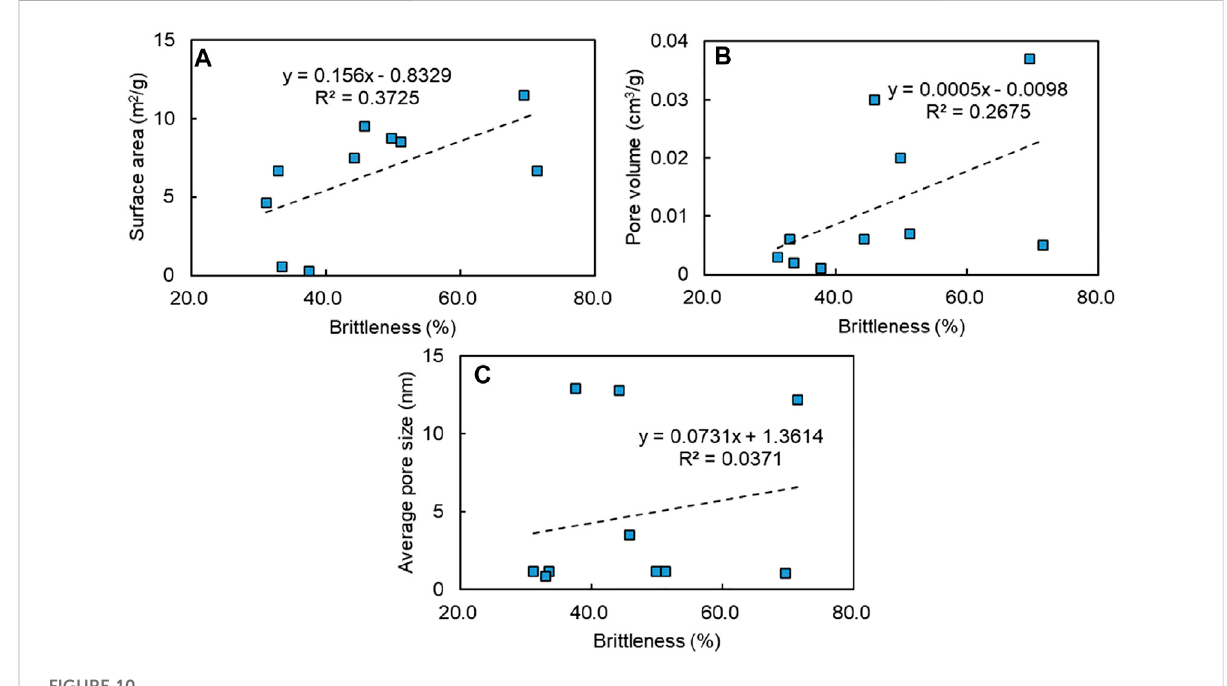
FIGURE 10 Pore structure parameters versus brittleness index in